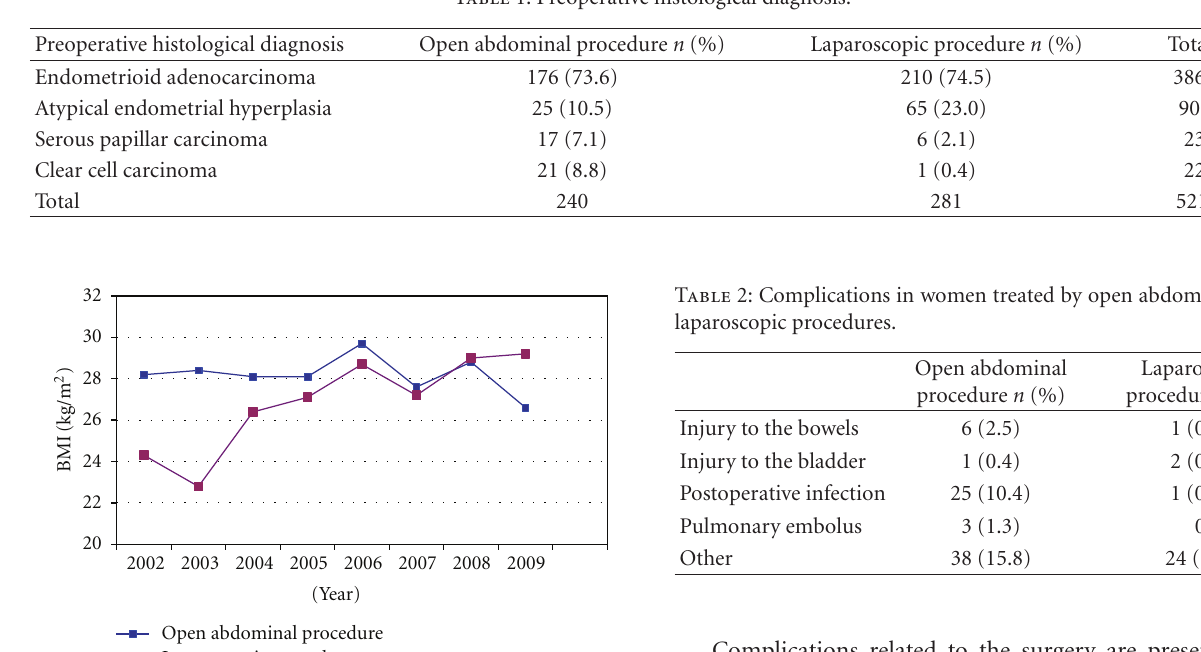
Table 1: Preoperative histological diagnosis.